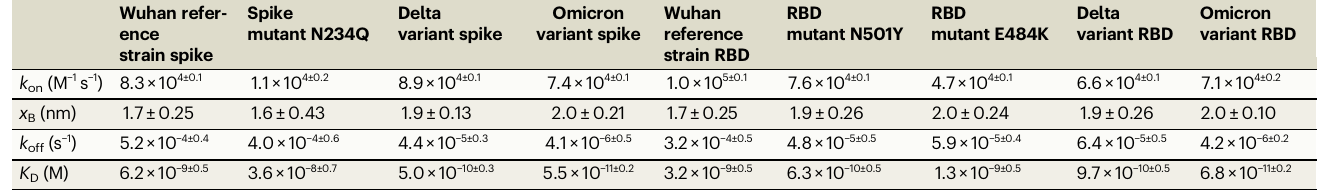
Table 1 | Summary of kinetic rate constants ( k on , k off ), width of energy barriers ( x B ), and af fi nities ( K D ) of SARS-CoV-2 Spike or RBD of Wuhan reference strain, de fi ned RBD mutants, and variants of concern determined using single molecule force spectroscopy